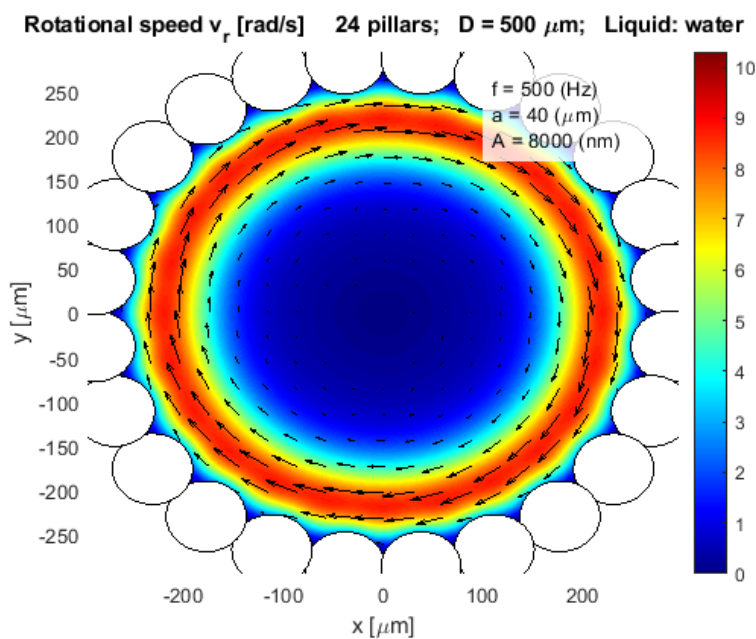
Figure 7. Rotational velocity of water stream v r in a closed pot-like layout.